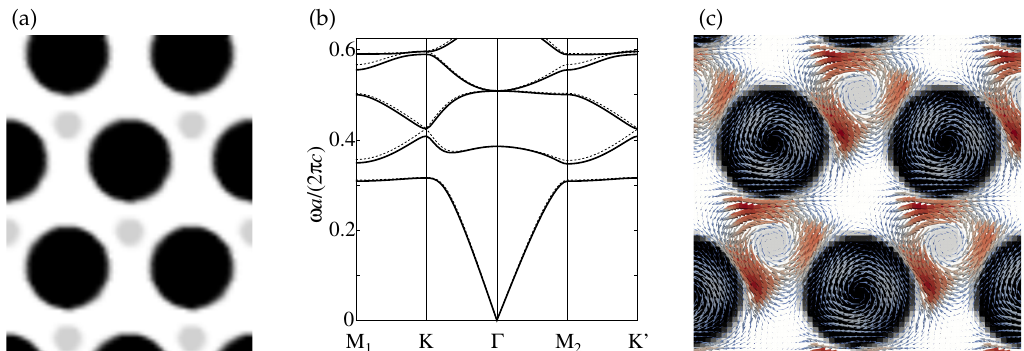
Figure 2. ( a ) A sample inversion asymmetric 2D photonic crystal for relative permittivity of 1, 3, and 12 in white, gray, and black regions, respectively. ( b ) Band diagram of TE modes for ( a ). Dotted lines show the case where the relative permittivity of gray rods is set to one. The vertical axis represents the dimensionless frequency ω a / ( 2 π c ) ( a : lattice constant; c : speed of light). ( c ) A sample optical tornado: energy flux density of a state at a K-point of the TE 2nd